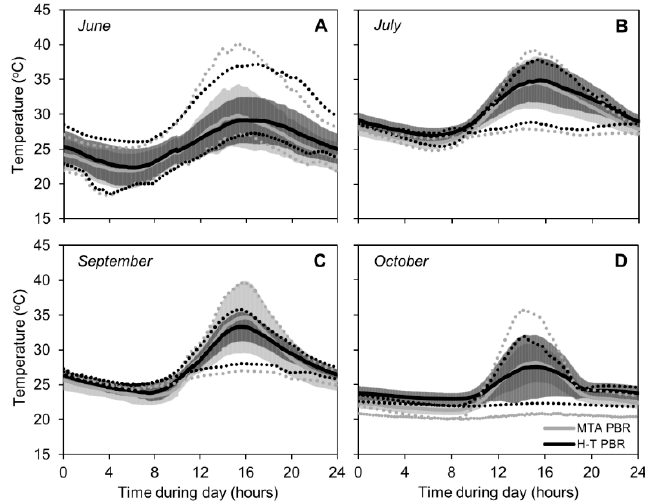
Figure 3. Temperature profiles in H-T PBR (black lines) and MTA PBR (grey lines) in June ( A ), July ( B ), September ( C ), and October 2018 ( D ). The full lines represent averages from 8 days of cultivation in each photobioreactor, the dark and light grey error intervals represent standard deviations for H-T PBR and MTA PBR, respectively. The doted lines represent temperature profiles in days when minimal and maximal temperatures during the light phase of the day were detected (within each month). Temperature in FPA PBR was regulated to 25 ◦